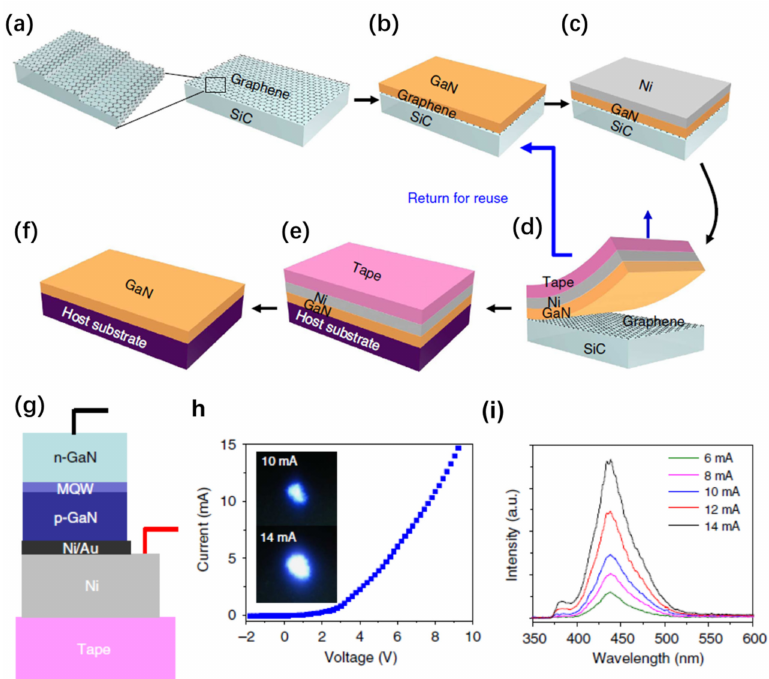
Figure 11. Schematic of a method for growing/transferring single-crystalline thin films on/from epitaxial graphene ( a – f ). ( g ) Schematic of a transferred visible LED device on the tape. ( h ) I–V char- acteristic of a transferred LED stack measured by applying positive bias on Ni and negative bias on n-GaN. The pictures of the LED emitting blue light are displayed in an inset. ( i ) Electroluminescence (EL) spectra of a transferred LED stack taken as a function of injection current. Adapted from